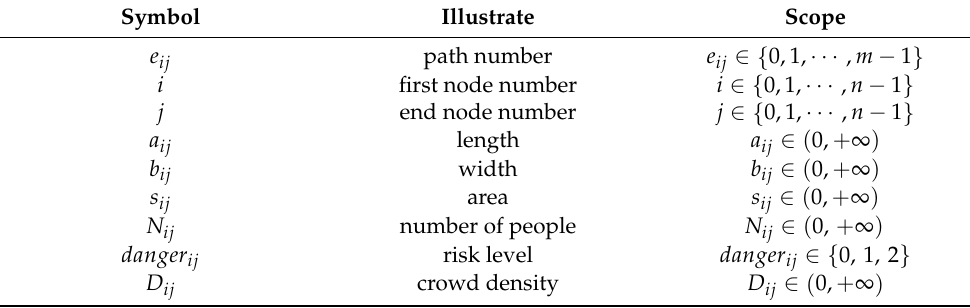
Table 2. Attribute description and scope of the